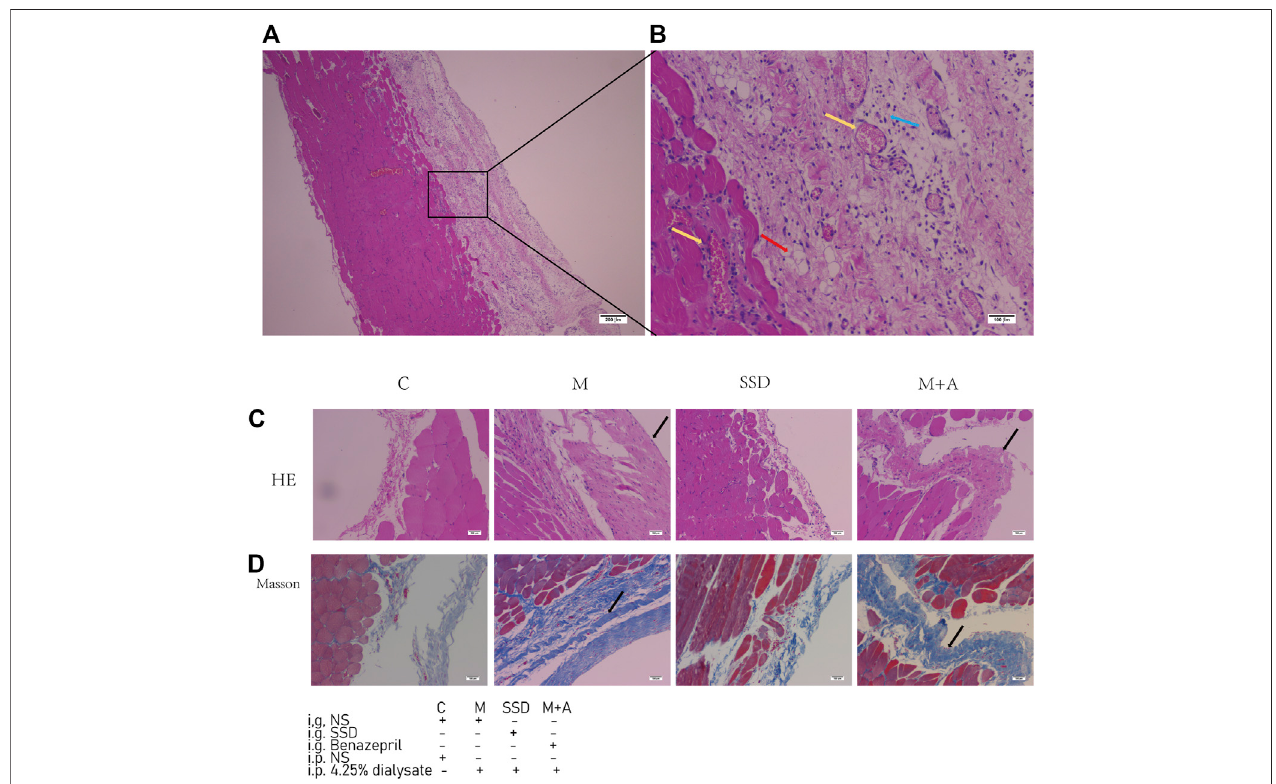
FIGURE 1 | H&E staining sections and Masson staining sections of peritoneal tissue. (A) H&E staining of a sample in the group M (B) H&E staining of the same sample the group M ( n (cid:2) 6 – 7) at higher magni fi cation (C , D) H&E and Masson staining of samples in the experimental groups. The yellow arrows indicate hyperplastic blood vessels. The red arrow indicates fat cells. The blue arrow indicates in fl ammatory cells. The black arrows indicate thickened peritoneum. Magni fi cations are 40 × in (A) and 100 × in (B – D)